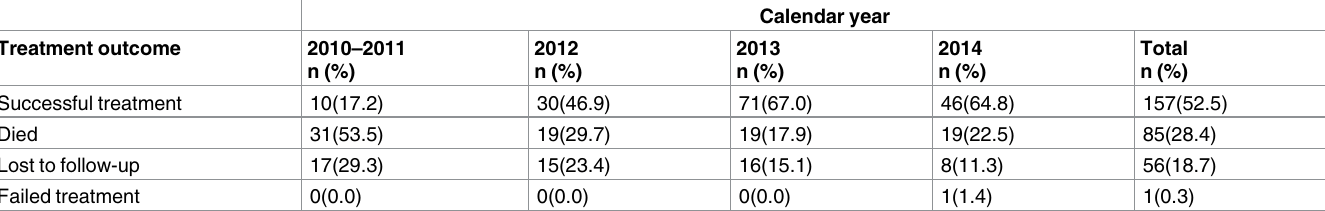
Table 2. Treatment outcomes of children over study period, TB clinic, Aminu Kano Teaching Hospital, Kano, Nigeria. Treatment